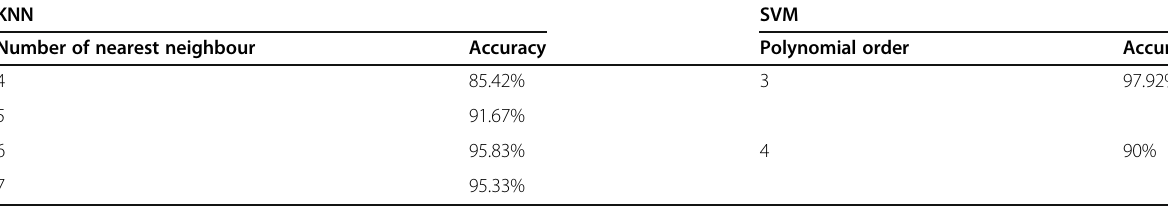
Table 3 Accuracy of KNN and SVM classifiers KNN SVM Number of nearest